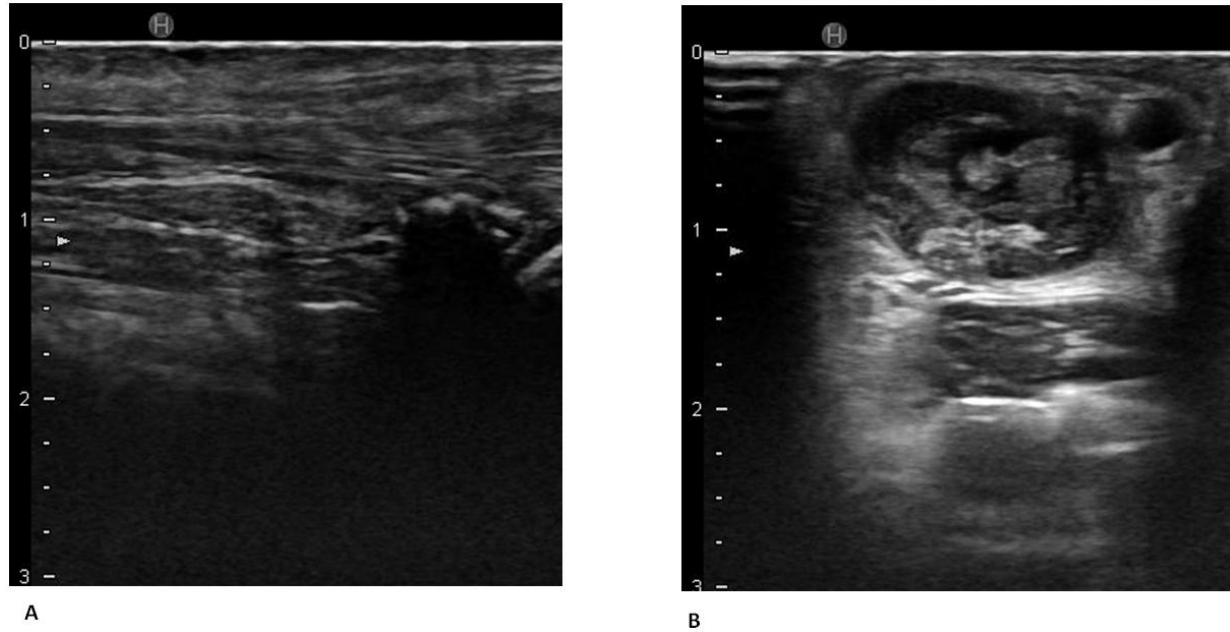
Figure 3 : Grade II Strain Longitudinal view grade II strain gastrocnemius and common tendons with grade I superficial digital flexor tendon The right SDFT appeared slightly thickened but showed overall good pattern. There was a mild amount of periosteal hyperechoic changes noted at the deep margin of the calcaneus. There was moderate disruption of the GT, mid tendon with normal identifiable pattern at the distal 1/3 of the tendon and more disruption note proximal to that point. The CT was moderately disrupted at the point of insertion with severe hypoechoic fib pattern and hyperechoic foci at the point of insertion at the calcaneus. In addition there were moderate areas of anechoic findings, indicating moderate fluid accumulation within the